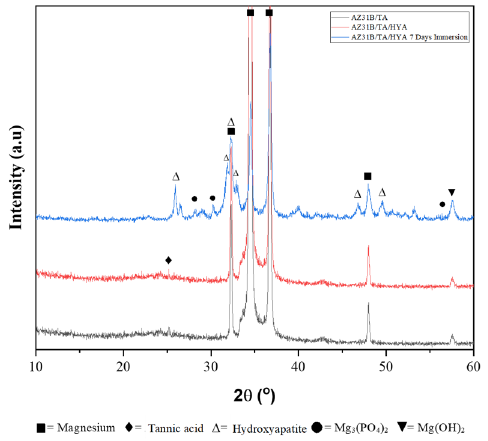
Figure 8. XRD results of samples AZ31B, AZ31B/TA, and AZ31B/TA/HYA after seven days of SBF immersion test.